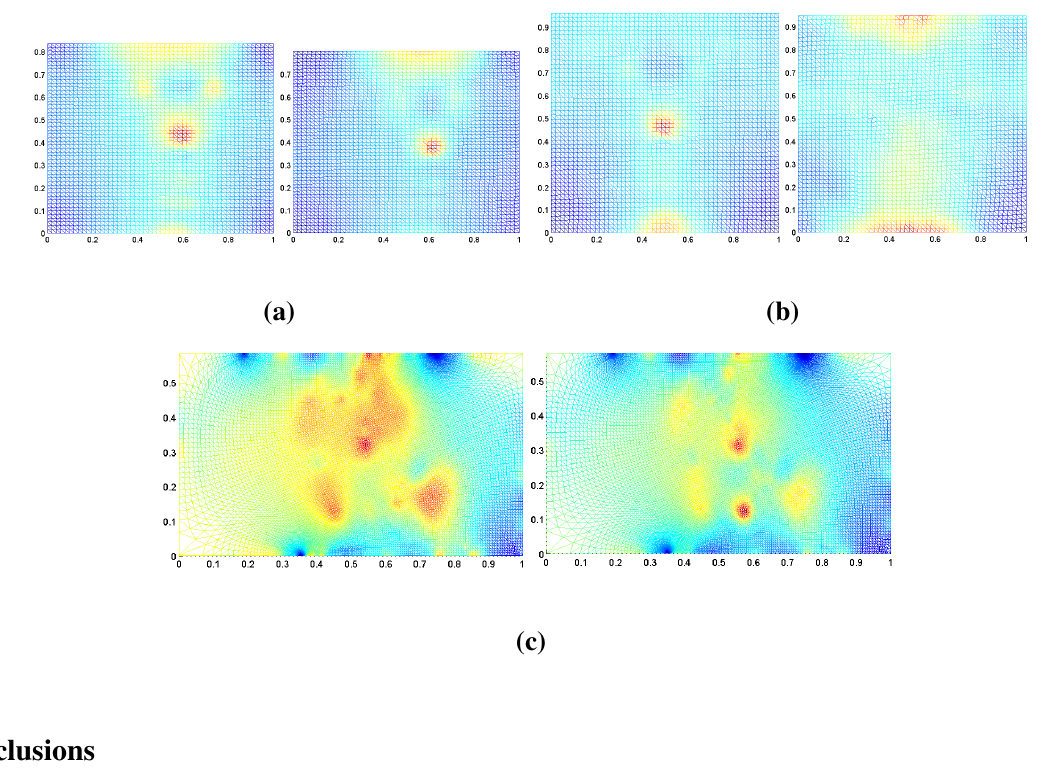
Figure 13. Harmonic mapping of the morphing surfaces from the 15th and 35th frames with arc-length parameterized boundary conditions from the original surface. The color represents the conformal factor of the corresponding morphing surfaces. ( a – c ) The morphing examples, correspondingly as in Figures 10–12,